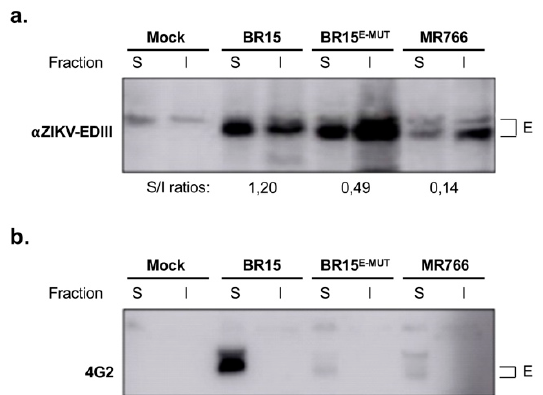
Figure 5. Conformational changes induced by residues E-152 / 156 / 158 of ZIKV E protein. In ( a ) and ( b ), HEK-293T cells were transfected with TMD2-prM / E constructs and antibiotics that were selected to raise stable cell lines. Cells were harvested and proteins extracts subjected to a fractionation. Protein fractions were immunoblotted with anti-ZIKV EDIII ( a ) or anti-E 4G2 ( b ) antibodies. S, soluble proteins; I, insoluble proteins. Band intensities were determined with ImageJ software and S / I ratios were calculated. Apparent discrepancies with cytometry experiments (Figure 2) regarding antibody reactivity are explained by experimental and recombinant protein overexpression versus viral infection conditions.